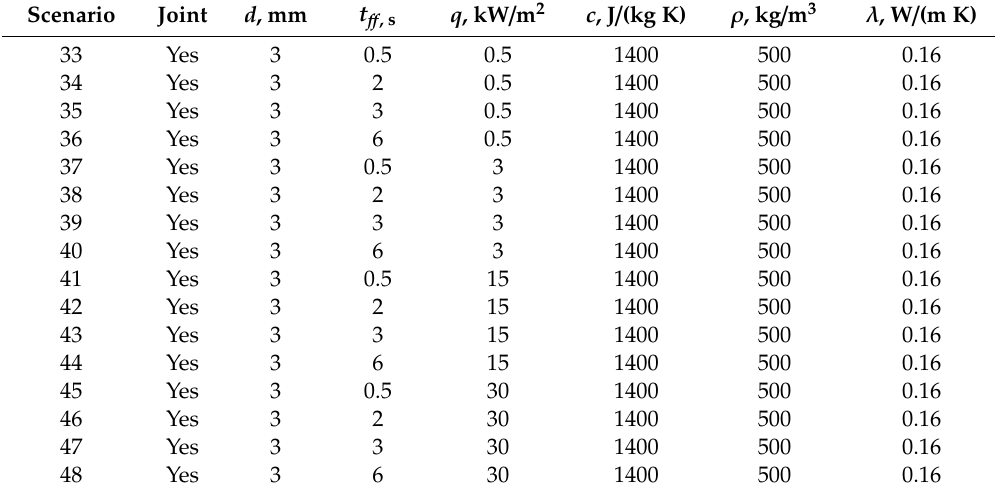
Table A6. The Main Scenarios of Forest Fire Impact on a Stem with a Joint. Part 3.